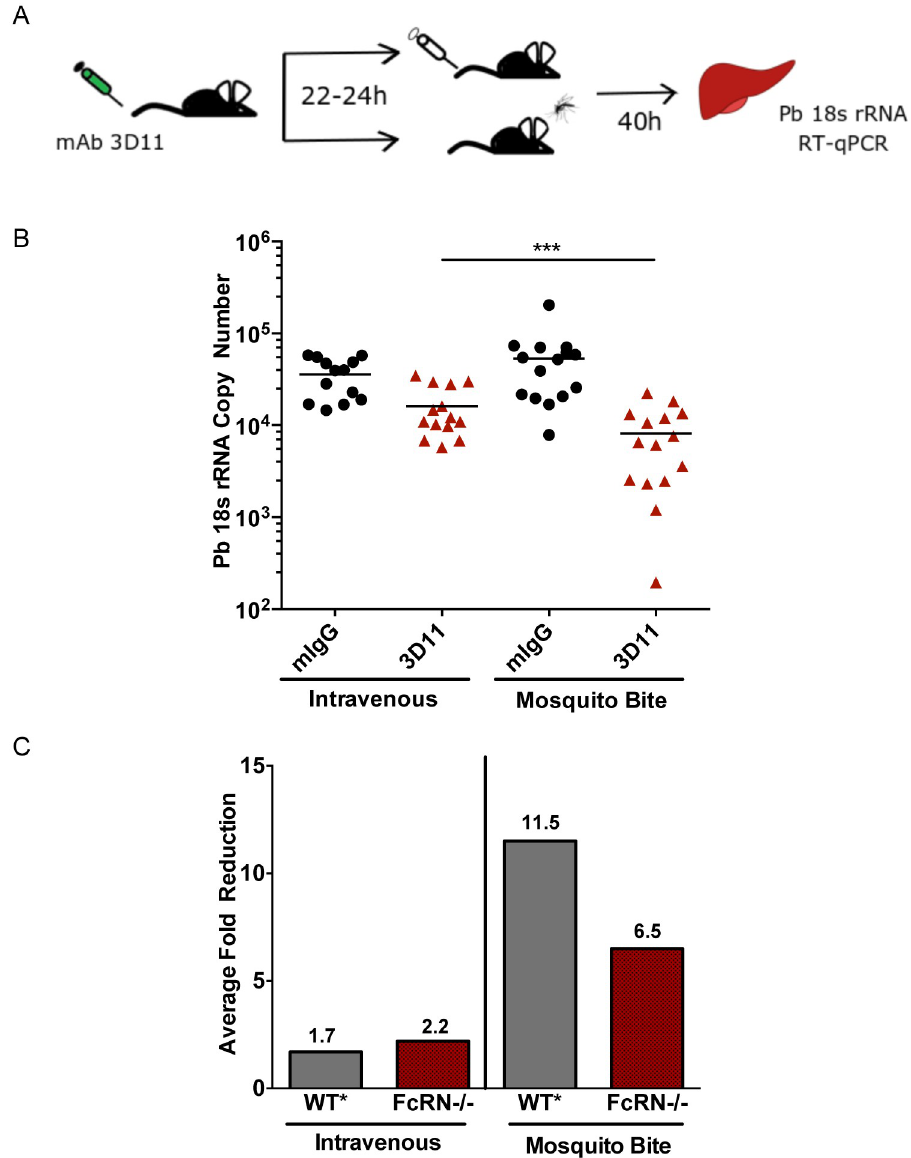
Fig 4. Efficacy of mAb 3D11 against IV and mosquito bite inoculated sporozoites in FcRn -/- mice. (A) . Schematic of the experimental workflow: FcRn -/- mice were inoculated IV with 25 μ g of mAb 3D11, specific for the major surface protein of sporozoites, or with an equivalent amount of mouse IgG. The next day, mice were challenged with 350 sporozoites inoculated IV or by 8 infected mosquito bites. 40 hrs post-sporozoite inoculation liver parasite burden was determined. (B) . Dot plot showing liver parasite burdens of mAb 3D11 and control IgG inoculated FcRn -/- mice, challenged by either IV or mosquito bite inoculation of sporozoites. Data are pooled from 3 independent experiments (n = 4–5 mice/group). No statistically significant difference was found between the control groups (mIgG groups IV vs MB). The difference between the mAb 3D11 groups IV vs MB was statistically significant (p < 0.001). Statistical comparisons were performed using a multi-level mixed effects model. (C) The average fold-reduction between control and mAb 3D11 groups, in both the IV challenged and mosquito bite challenged mice was calculated by taking the negative inverse of the ratio [-1/(3D11:mIgG)] of the average P . berghei 18s copy number. The fold-reduction in FcRn-/- mice, IV and mosquito bite challenged, is calculated using the data in panel B. The fold-reduction for the same concentration of mAb 3D11 in wild-type (WT * ) mice is from a previous publication [9] and included for comparison.